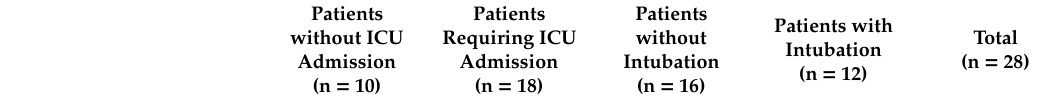
Table 2. Results of subjective and objective CT